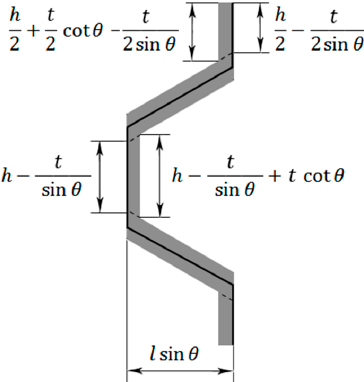
Figure 3. Dimensions of half a unit cell.